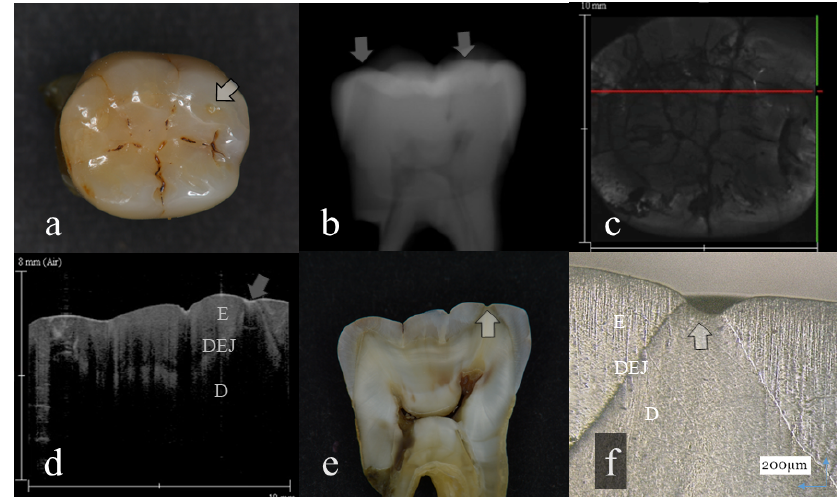
Figure 4. Tooth wear with slight dentin exposure (score 3); ( a ): Occlusal view. Occlusal cusps were